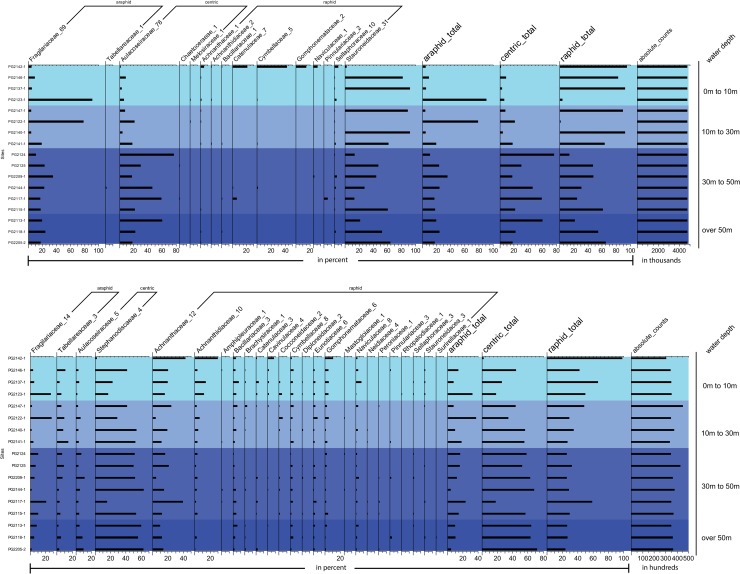
Diatom relative abundance.Percentages of diatoms retrieved by the genetic (a) and morphological (b) approach of surface samples from Lake Bolshoe Toko ordered by water depth. Numbers following the family names are the number of retrieved distinct sequence or morphological diatom types identified as belonging to the diatom family. Family assigned sequences and counts are summed up in three groups–araphid, raphid and centric diatoms. The genetic dataset has been rarefied to account for large differences in sequence reads per site. Morphological data are not rarefied as the number of absolute counts does not differ significantly.